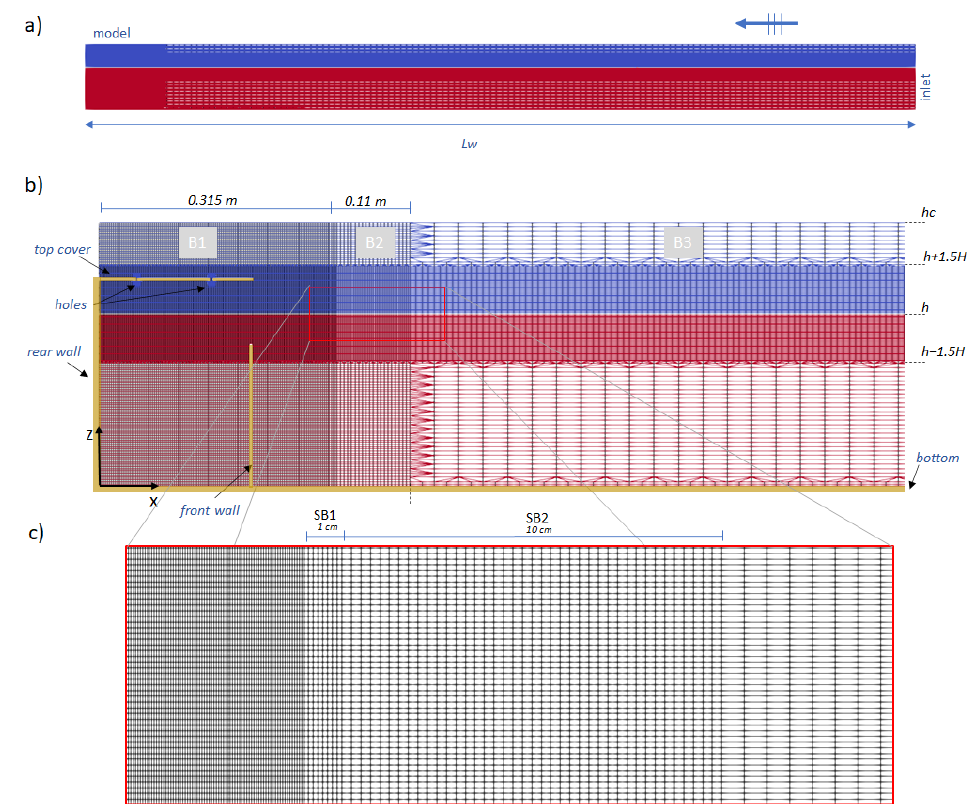
Figure 4. Computational domain used for the numerical simulation of the composite caisson: ( a ) cross section of the entire domain; ( b ) detail of the grid close to the model; ( c ) detail of the grid in the transition zone. The symbols indicate B 1, B 2, and B 3 the name of the three blocks; SB 1 and SB 2 the name of the two sub-blocks; hc the height of the numerical flume; h the mean water level; and H the height of the incident regular